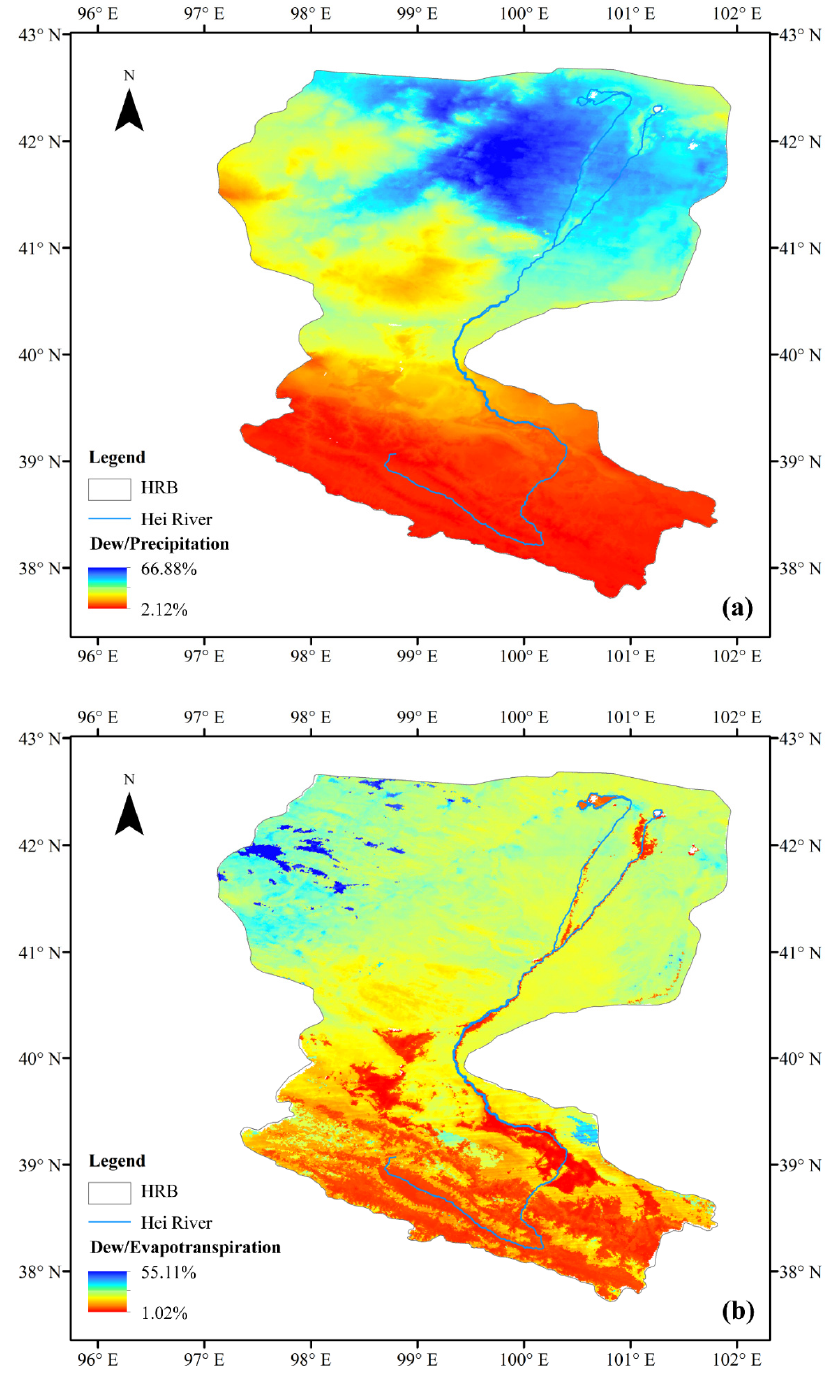
Figure 12. The ratio of annual dew to precipitation ( a ) and to evapotranspiration ( b ) in the HRB. Many studies in arid and semiarid zones have shown the non-negligible character of the dew [21,61]. For example, in a closed desert valley in northeastern Nevada, USA, where precipitation is the only source of water, the cumulative amount of evapotranspi- ration (160 mm) during the water year 1993–1994 was greater than that of precipitation